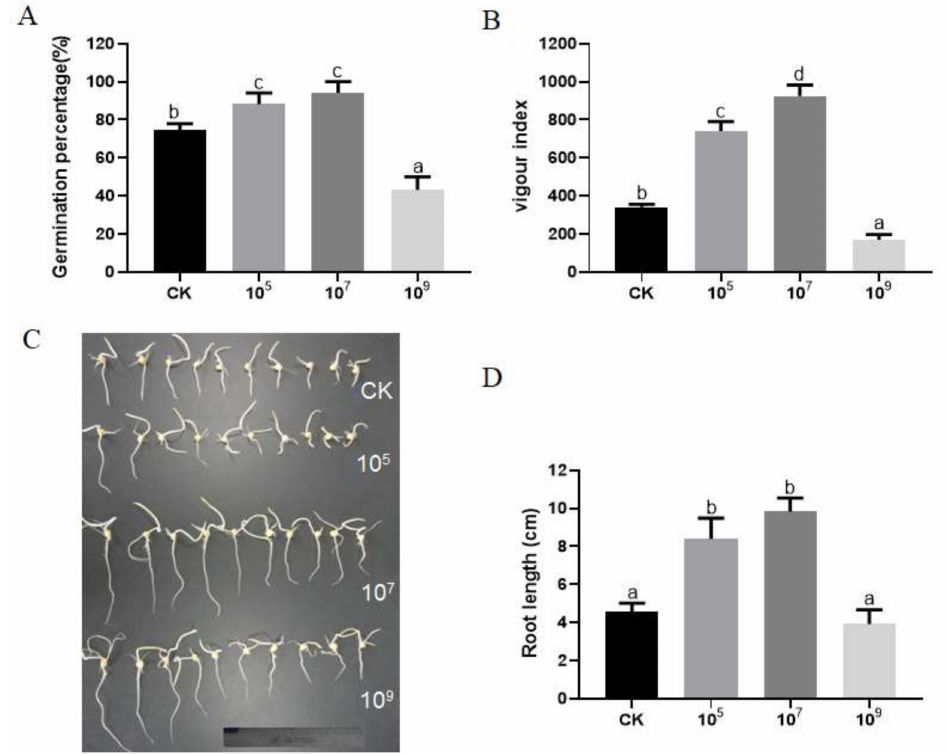
Figure 1. The seed germination percentage ( A ), vigour index ( B ) and root length ( C , D ) of corn under four concentrations of the R. aquatilis JZ-GX1. Vertical SD bars were added above the histograms, and the different letter above the SD bars indicates very significant difference according to Tukey’s HSD at p ≤ 0.01. The portion of a ruler painted in blue in panel C is 2